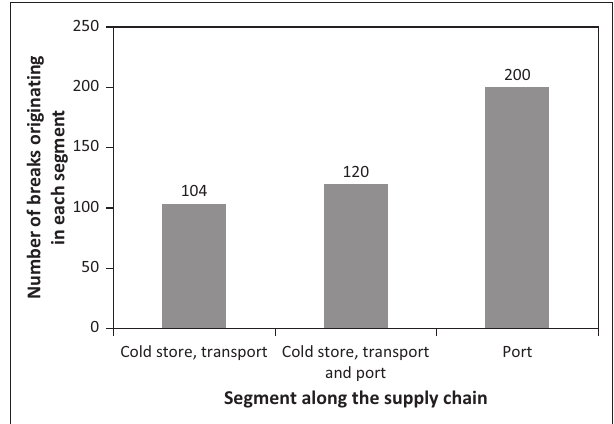
FIGURE 3: Number of breaks in the cold chain during the 2012/2013 season.